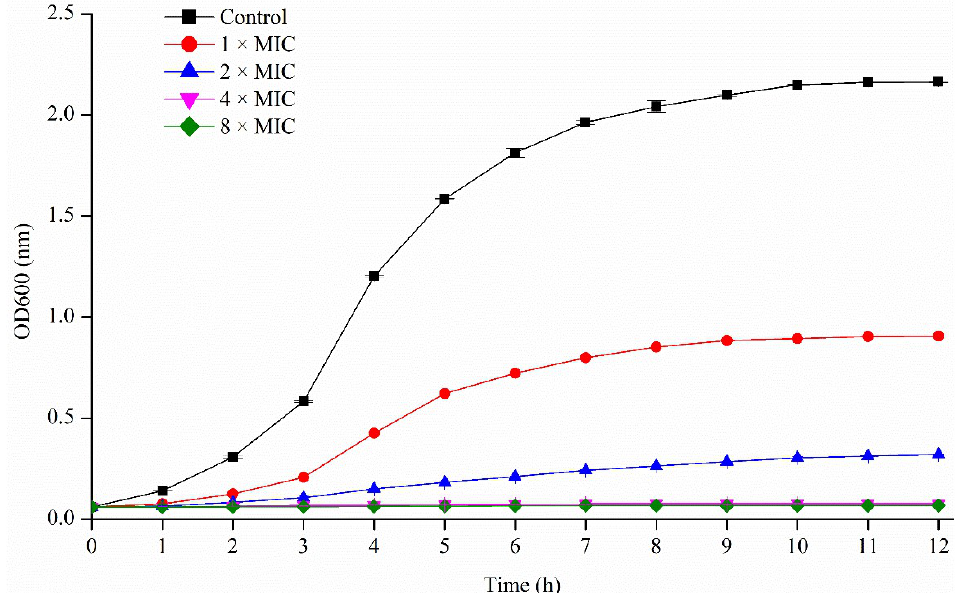
Figure 2. Growth curve of S. aureus with different concentrations of pseudopyronine B (1 × to 8 × MIC). The control group represents only S. aureus in the medium, without a test compound.